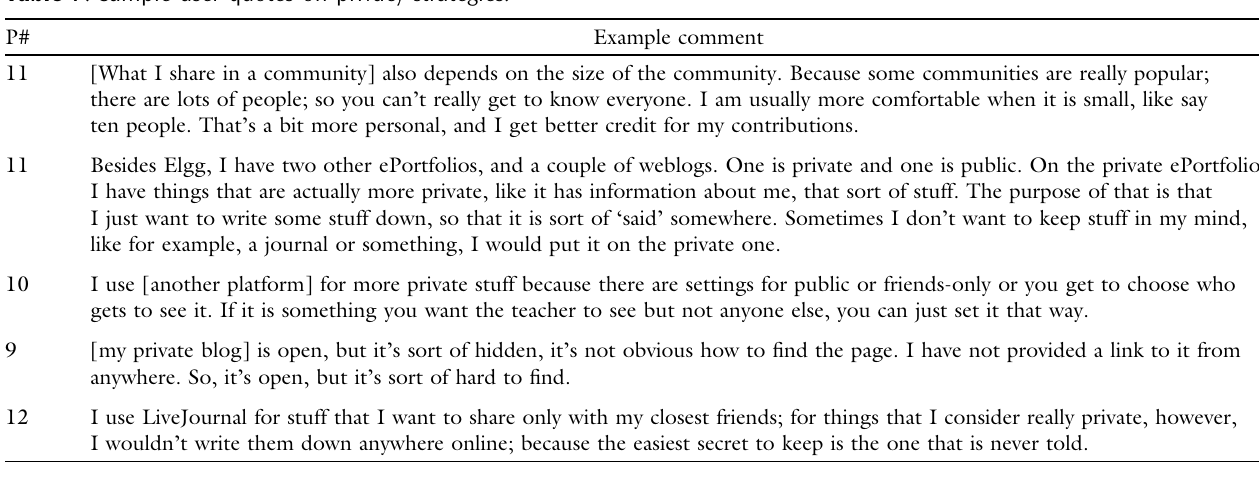
Table 7. Sample user quotes on privacy